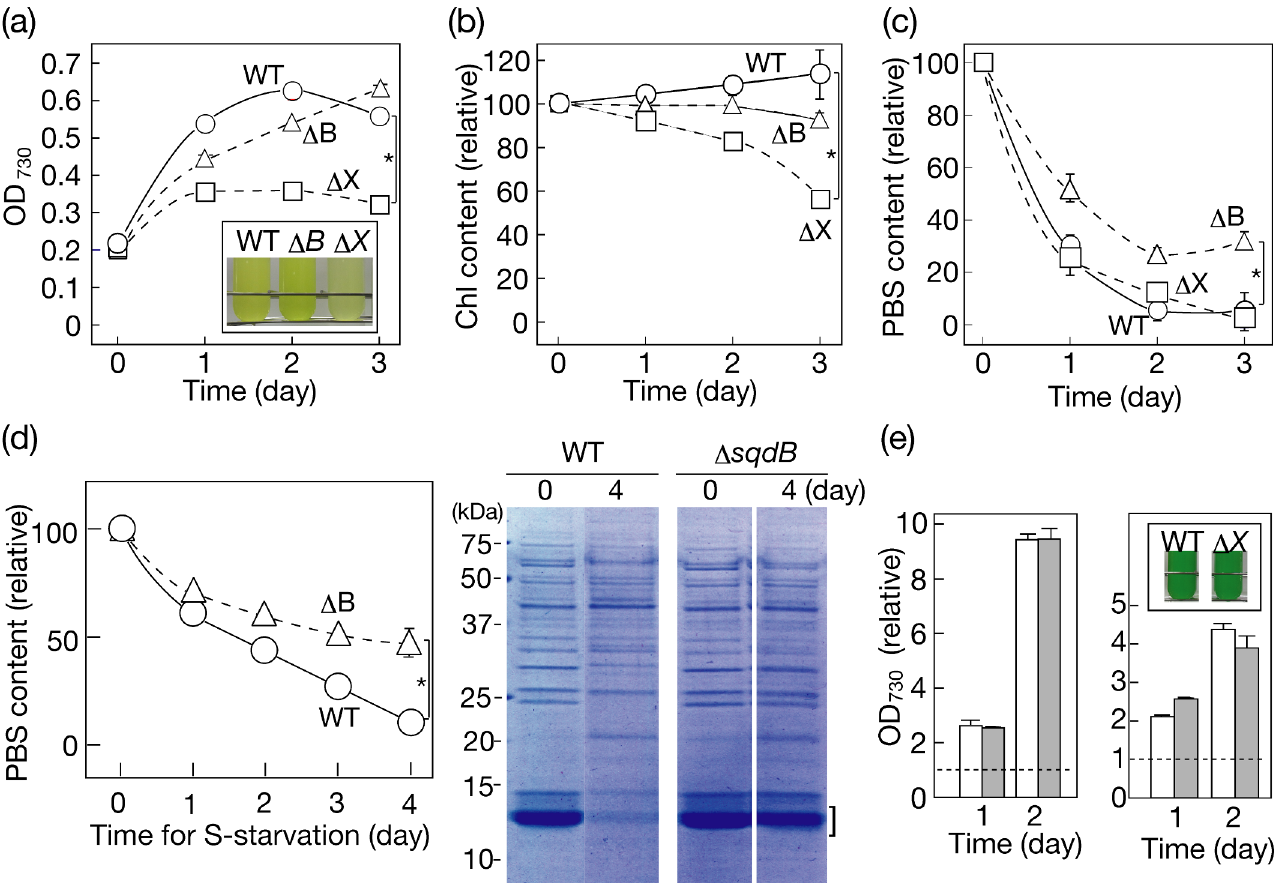
Fig 5. Effects of Δ sqdB and Δ sqdX in Synechococcus on cellular responses to S-starvation and on recoveryof cell growth with re- supplementation of sulfate. Cell growth (a, OD 730 values), and the Chl (b) and phycobilisome (c, d) contents duringS-starvation were investigated in the WT (open circles), and disruptants of Δ sqdB (open triangles) and Δ sqdX (open squares), respectively. The inset in (a) shows photographsof normally, weakly, and strongly bleachedcultures of the WT, and Δ sqdB ( Δ B ) and Δ sqdX ( Δ X ) disruptants, respectively. (d) Cells were starved for S with illuminationwith light at a milderintensity (14 μ molphotonsm -2 s -1 ) than usual[(c), 24 μ molphotonsm -2 s -1 ]. The phycobilisome content was determined by spectroscopy (c; d, left) or SDS-PAGE of solublefractions of mechanically disruptedcells (d, right). (e) Cells starved of S for 3 days wereshifted to S-repleteconditionsfor recovery from the retardedgrowth. Left, S-starved cellsof the WT (white bars) and Δ sqdB disruptant(grey bars) were initiallyadjustedto 0.1 in OD 730 valuewith S-repletemedium.Right, S-starved cells of the WT (white bars) and Δ sqdX disruptant(grey bars) were initiallyadjustedto an OD 730 valueof 0.2 with S-replete medium. The two-fold higherinitialvalueof OD 730 for the Δ sqdX disruptantrelative to that for Δ sqdB one was to avoidpossiblephotodamage in the Δ sqdX one, owingto its severe damagesto cell growth and Chl accumulation (Fig 5A and5B). Brokenlines correspond to initiallevelsin the cultures. The inset in (e) shows photographs of 2-day cultures of the WT and Δ sqdX ( Δ X ).The valuesshownare the averages ± SD for three distinct groupsof data. The significance of differenceswas evaluatedby Student’s t test. * P < 0.05.